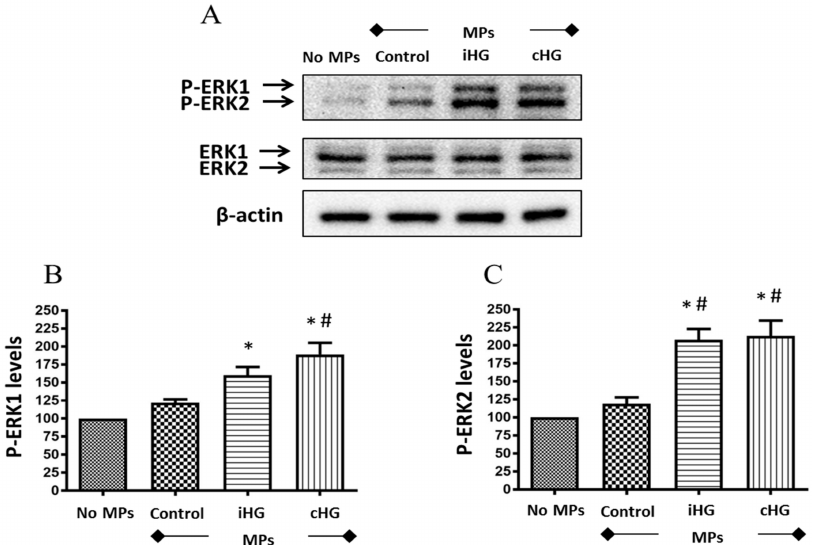
Figure 3. High glucose-derived microparticles (MPs; 10 µ g / mL) induce phosphorylation of the downstream target of extracellular signal-regulated kinase (ERK) pathway—ERK1 / 2—in naïve renal proximal tubular cells. ( A ) Representative Western blot of P-ERK1 / 2; and ( B , C ) densitometry analyses of P-ERK1 and P-ERK2 levels normalized to β -actin. Values were expressed as mean ± SEM; n = 3; * p < 0.05 versus no MPs (control); # p < 0.05 versus control MPs; P-ERK1 / 2 and ERK1 / 2: Phosphorylated and total extracellular signal-regulated kinases 1 / 2; iHG: Intermittent high glucose; cHG: Continuous high